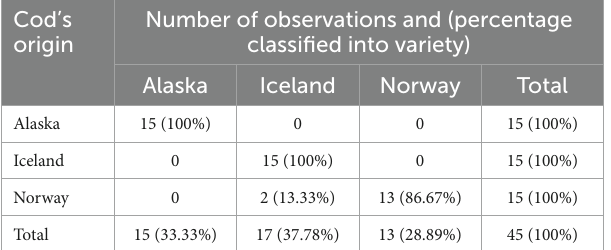
TABLE 5 Classification matrix of cross-validation for cod origin [number of observations and (percent classified into variety)]. Cod’s Number of observations and (percentage origin classified into variety) Alaska Iceland